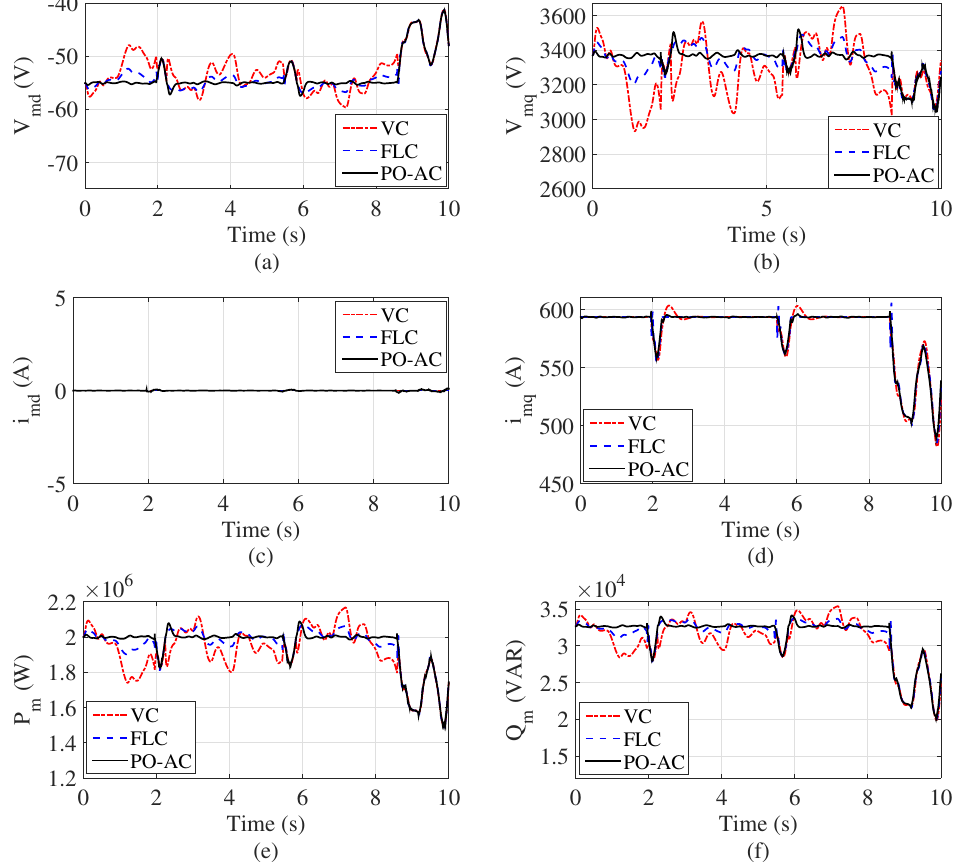
Figure 9. Responses of the PMSG to random wind speed. ( a ) d-axis voltage V md . ( b ) q-axis voltage V mq . ( c ) d-axis current i md . ( d ) q-axis current i mq . ( e ) Active generating power P m . ( f ) Reactive generating power Q m .